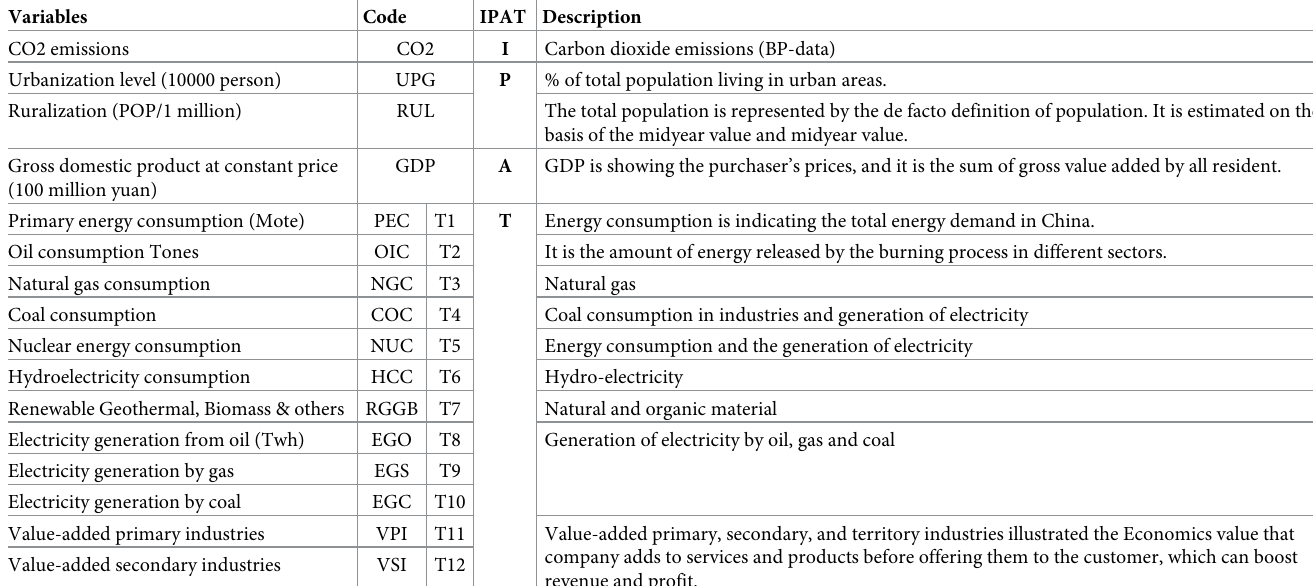
Table 1. Variables definition and